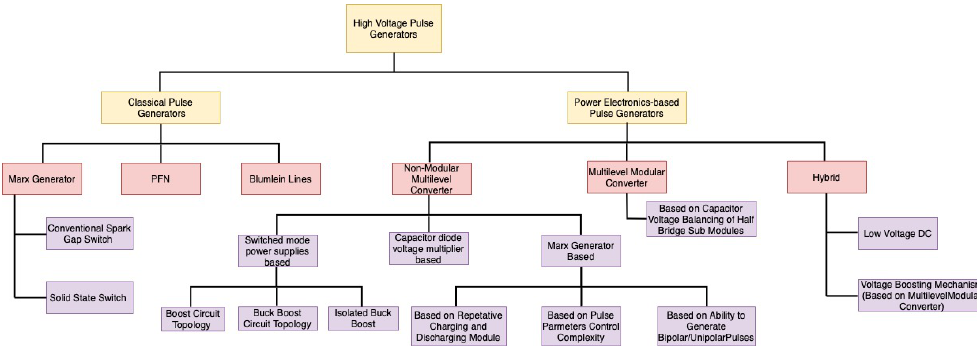
Figure 3. Classification of High Voltage Pulse Generators [28].